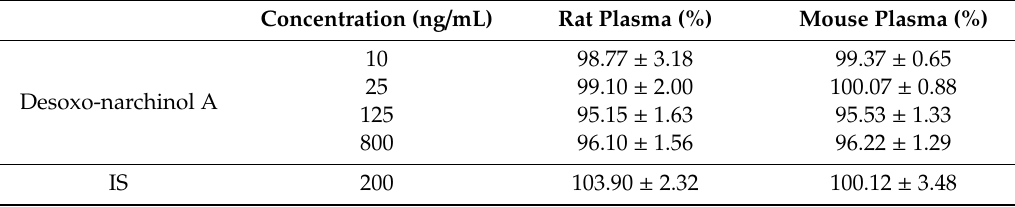
Table 3. Total recovery (%) for desoxo-narchinol A and IS in rat and mouse plasma ( n =